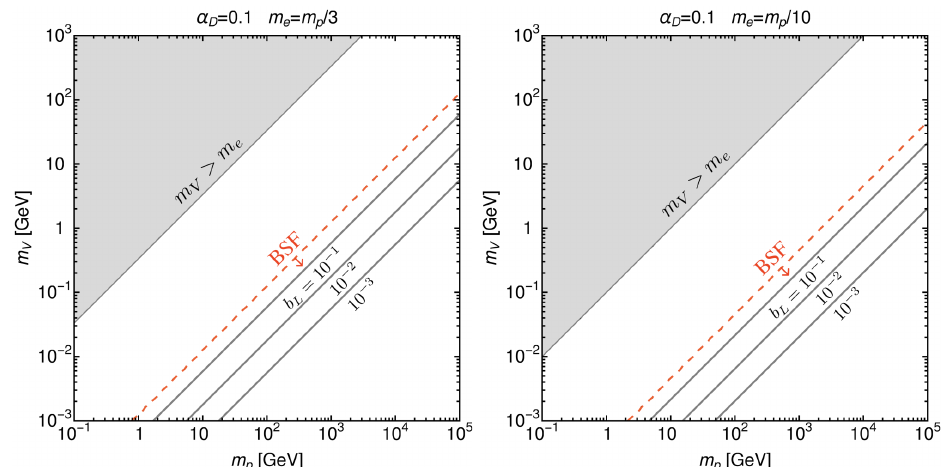
Figure 3: The branching ratio of the BSF into the longitudinal polarisation state of the dark photon, b , for two sets of parameters. Bound state formation is kinematically L possible below the red dashed